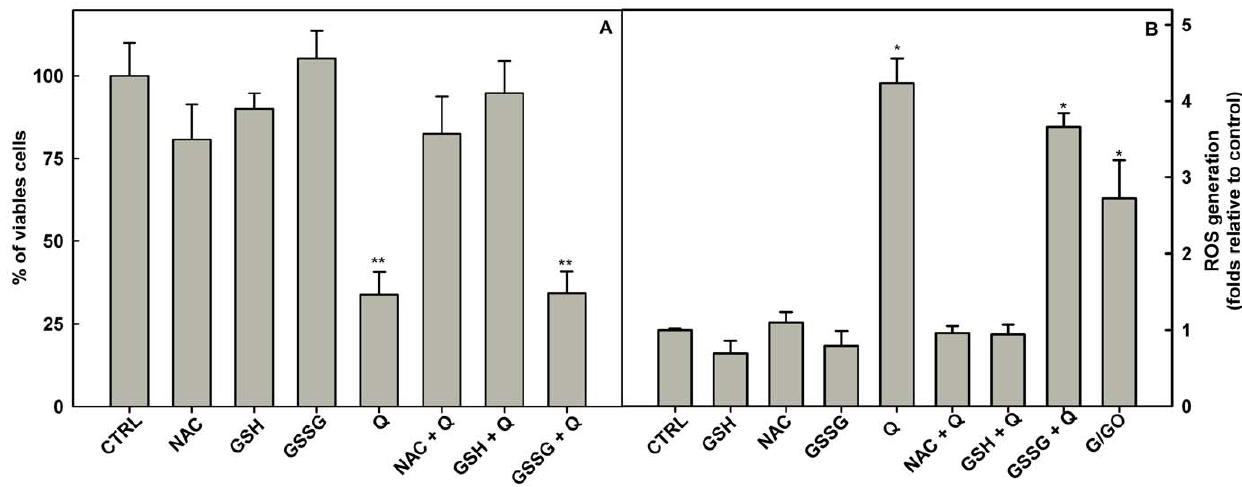
Figure 6. Effect of N-Acetyl-L-cysteine, Reduced Glutathione and Oxidized Glutathione on quercetin-induced cell death (A) and ROS formation (B). L. amazonensis was cultivated in Schneider’s Drosophila medium at 26 u C as described in Materials and Methods for 48 h in the presence of N-Acetyl-L-cysteine, reduced glutathione and oxidized glutathione in the absence or in the presence of quercetin. N-Acetyl-L-cysteine, reduced glutathione and oxidized glutathione were solubilized in PBS and quercetin was solubilized in DMSO. N-Acetyl-L-cysteine, reduced glutathione and oxidized glutathione were added to the culture to a final concentration of 300 m M, and quercetin was added to the culture to a final concentration of 96 m M. Values shown are the mean 6 standard error of three different experiments. In the control (absence of quercetin), the same volume of vehicle (DMSO 0.2%) was added to the growth medium. Generation of ROS was measured using fluorescent dye H 2 DCFDA as described under Materials and Methods. Data are expressed as fold increase in ROS production relative to control. Values shown are the mean 6 standard error of three different experiments. Positive control for ROS generation was obtained by addition of 20 units/ml glucose oxidase + 60 mM glucose for 20 minutes. CTRL - control; NAC - N-Acetyl-L-cysteine; GSH - Reduced Glutathione; GSSG - Oxidized Glutathione, Q 2 Quercetin and G/ GO 2 Glucose + Glucose oxidase. ** indicates significant difference relative to the control group ( p , 0.01); * indicates significant difference relative to the control group ( p ,